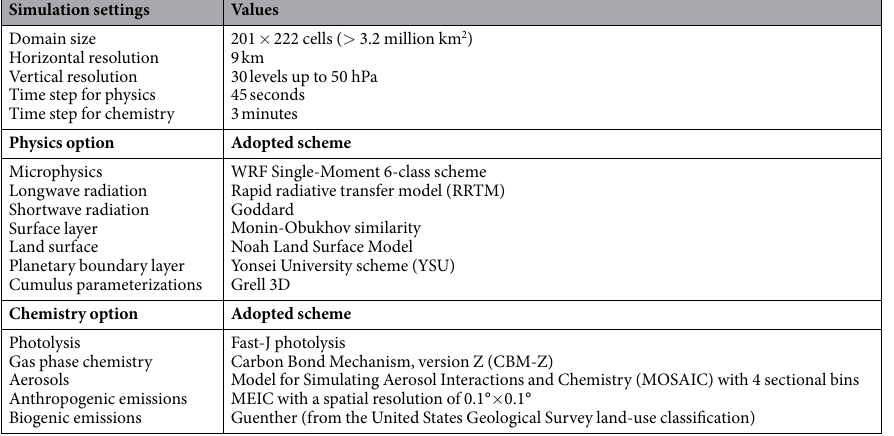
Table 5. List of the experimental settings and schemes used in